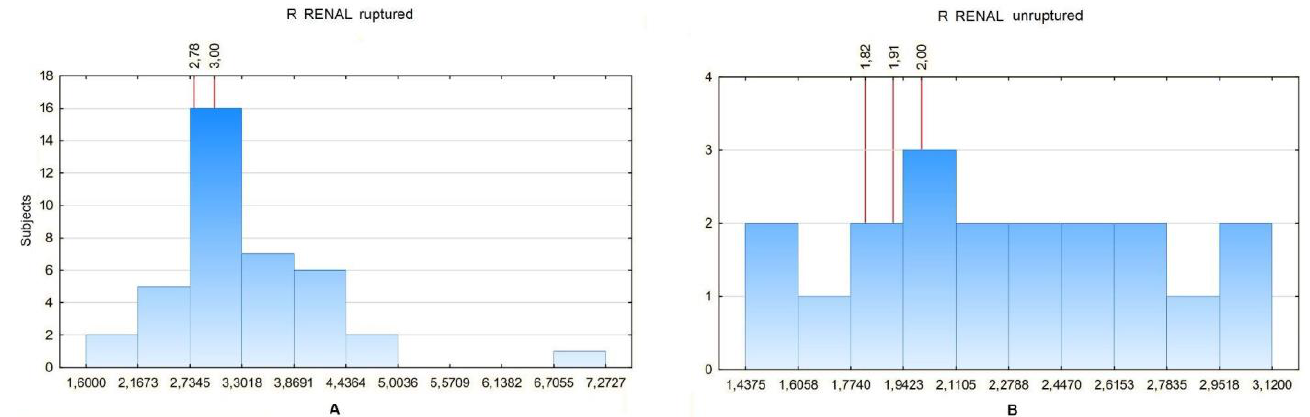
Figure 10. ( A ) R RENAL values distribution in a certain number of patients with ruptured aneurysm with neck segment absent. For the 20th percentile: 2.78, 25th percentile: 3, 30th percentile: 3. ( B ) R RENAL values distribution in a certain number of patients with unruptured aneurysm with neck segment absent. For the 20th percentile: 1.82, 25th percentile: 1.91, 30th percentile: 2.